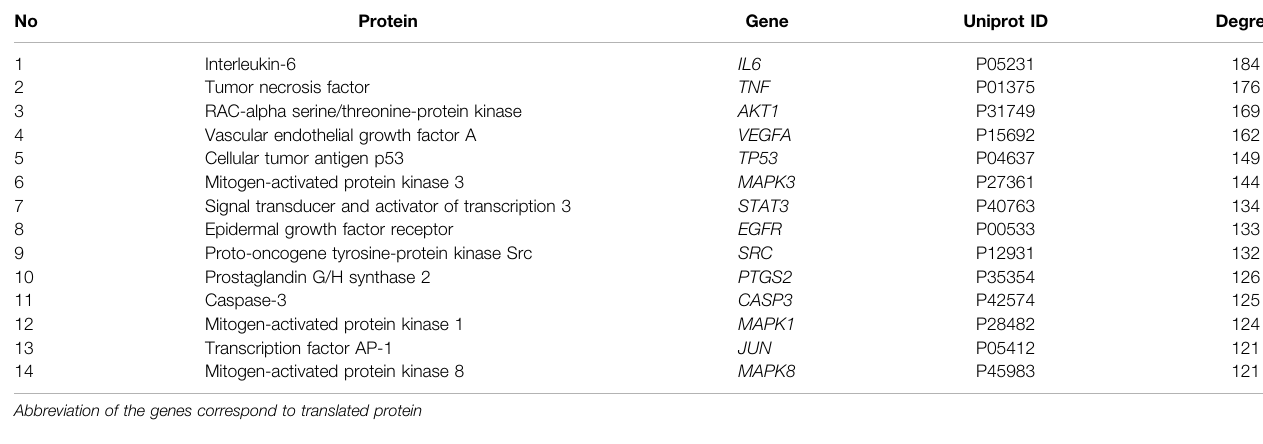
TABLE 2 | Genes with greater than three times the average degree value.